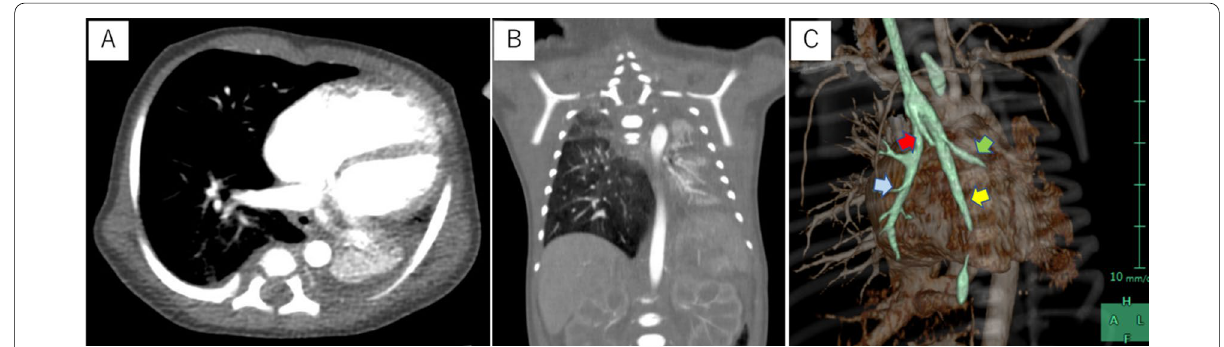
Fig. 2 Contrast-enhanced computed tomography (CT) showing an atelectatic unilobe in the left lung ( A , B ). Three-dimensional CT image representing the tracheal trifurcation in three directions; the right main bronchus (blue arrow), blind-ended branch considered to be the left main bronchus (red arrow), and dorsal branch bifurcated to left lower lobe bronchus (green arrow) and the lower esophagus (yellow) ( C